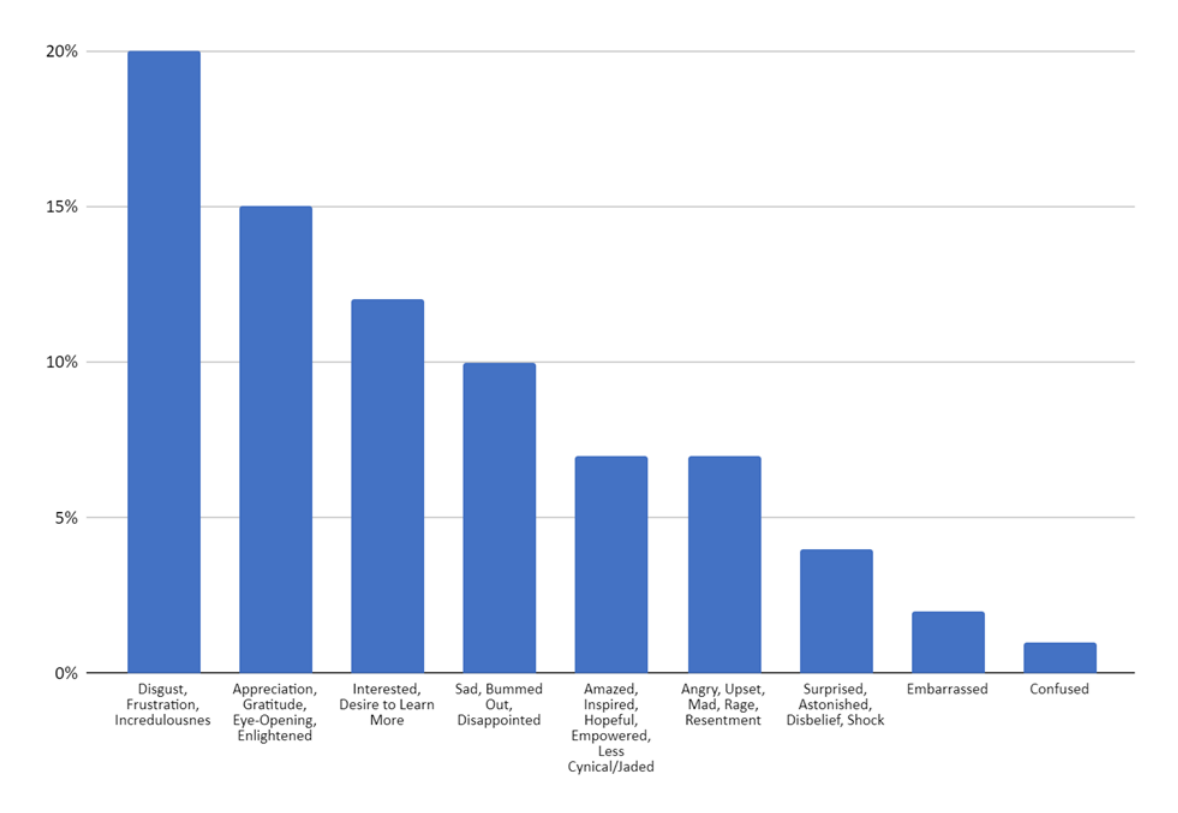
Table 3: Expressed Feelings Following Experience with this